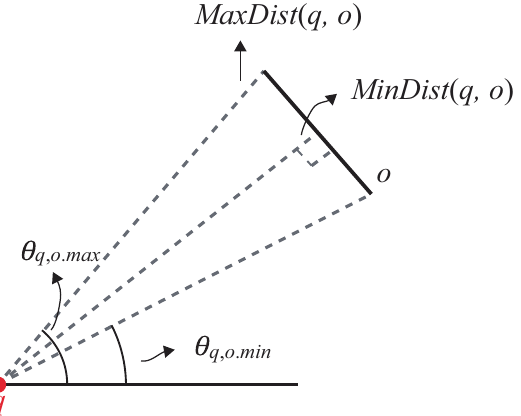
Figure 7. Angular and distance bounds of an